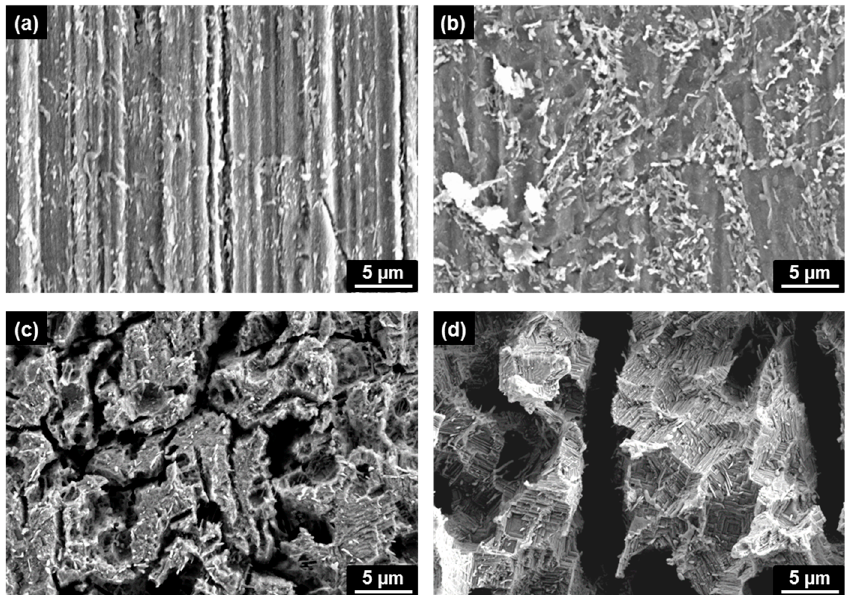
Figure 10. Corrosion morphology of SA508 coupons after the immersion test: ( a ) uncoupled SA508 in 10% EDTA-based solution at 93 °C; ( b ) uncoupled SA508 in 20% EDTA-based solution at 121 °C; ( c ) SA508 coupled with magnetite in 10% EDTA-based solution at 93 °C; and ( d ) SA508 coupled with magnetite in 20% EDTA-based solution at 121 °C.